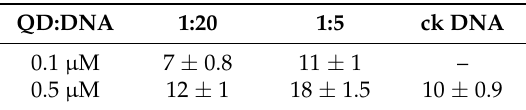
Table 1. Red shifts for two different concentration ratios (1:20 and 1:5) of quantum dots and DNA at a DNA concentration of 0.1 µ M and 0.5 µ M. Results for control DNA are also